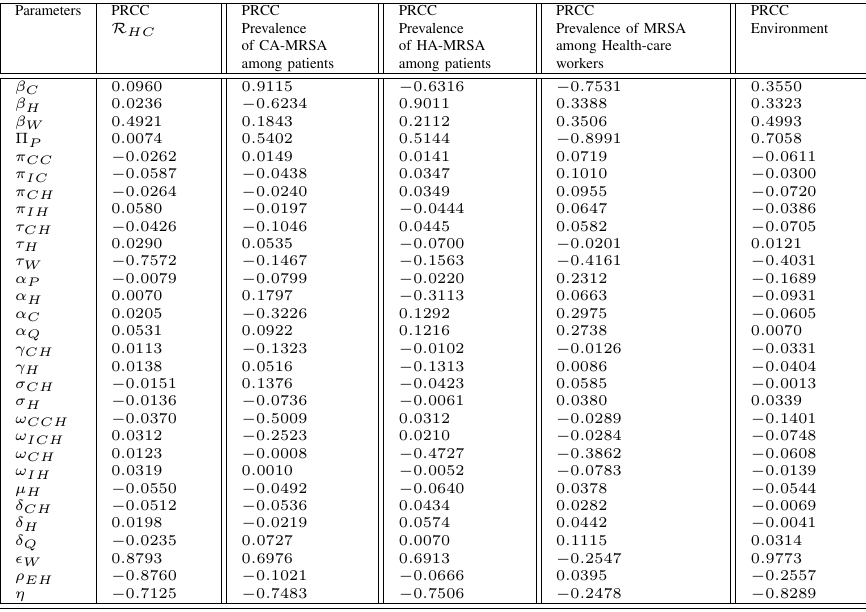
(e) the key parameters influencing the hospital environment are environmental contamina- tion rate ( ε W ), hand washing compliance rate ( η ), the admission rates into the hospital ( Π P ), the transmission probability of health- care workers per contact with patients ( β W ), the environmental contamination rate ( ε W ), the transmission probability of CA-MRSA per contact with health-care workers ( β the transmission probability of HA-MRSA per contact with health-care workers ( β